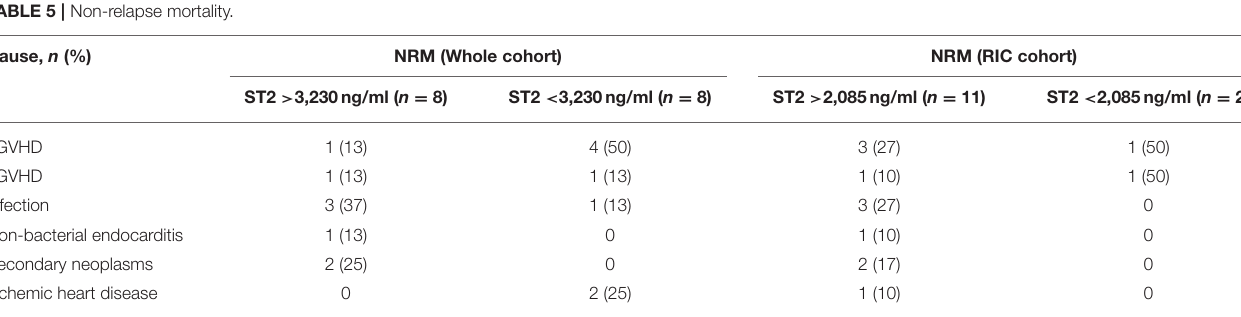
TABLE 5 | Non-relapse